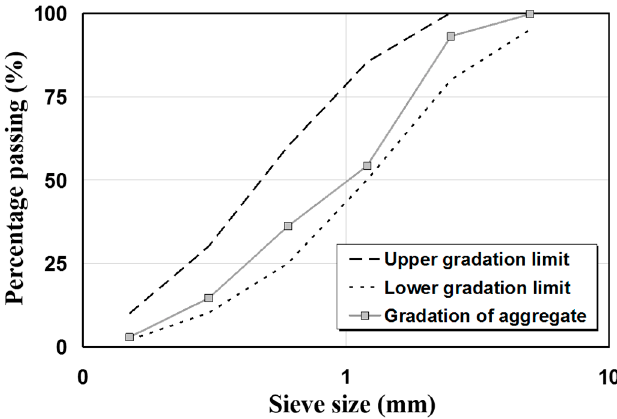
Figure 1. Gradation curve of silica sand.